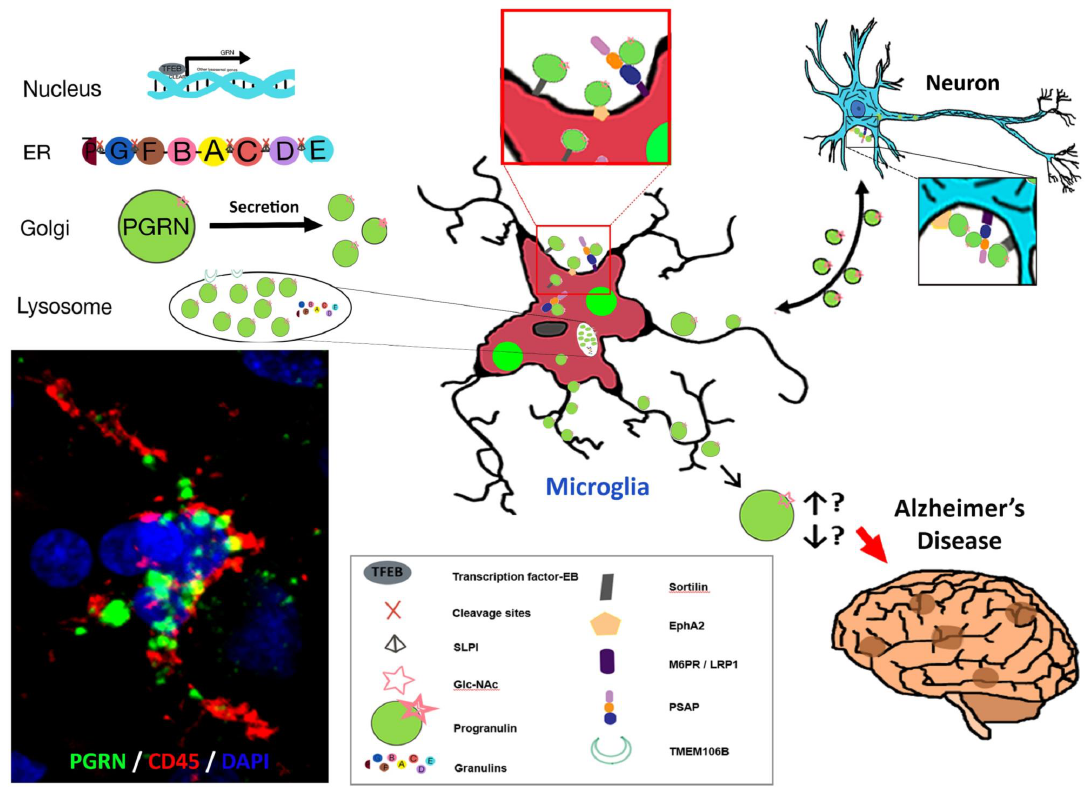
Figure 3. Some Features of PGRN, microglia and Alzheimer’s disease. ( A ) Confocal image of PGRN positive (green) accumulations within a CD45 positive microglia in a human AD brain. ( B ) Intracellular processing of Grn to PGRN and granulins. ( C ) The adjacent diagrams suggests how features identified in vivo and in vitro might interact and be involved in PGRN function in AD. There are unanswered questions about the interaction of proteins with PGRN intracellularly and with secreted PGRN. The direction of interaction of PGRN between microglia and neurons is unresolved. The diagram represents PGRN as accumulations as seen in panel A but is believed to at least be present as dimers. The final unresolved issue is whether excess of PGRN precipitates Alzheimer’s disease pathology or whether it is a deficiency of PGRN or loss of function that has this